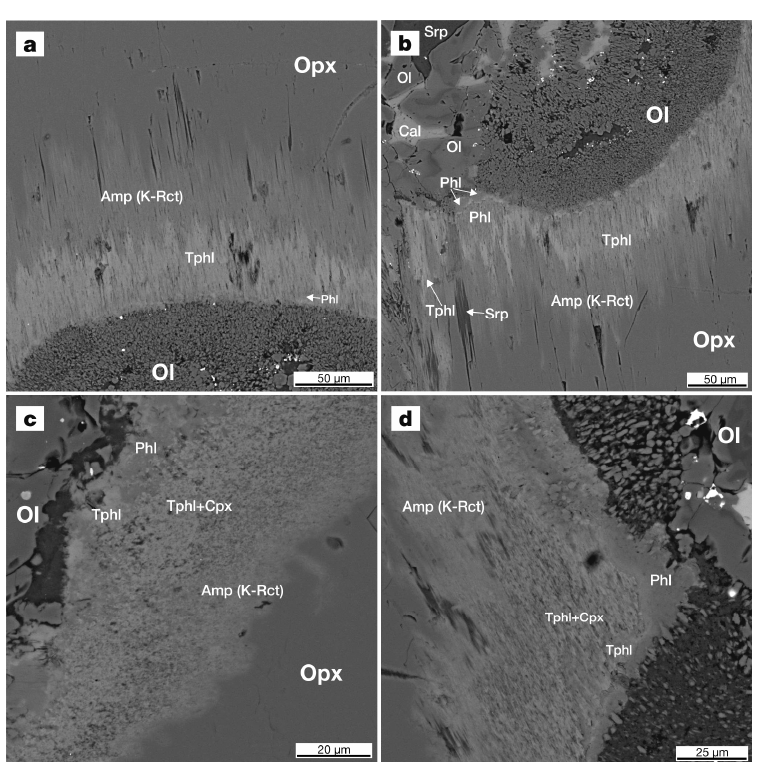
Figure 4. ( a–d ) BSE images showing the layered internal texture and mineral composition (Ol → Phl → Tphl ± Cpx → K-Rct) of the reaction zones between the crystallized melt inclusions and host orthopyroxene. Mineral abbreviations are those described in the Section “Materials and Methods” and Table 1.